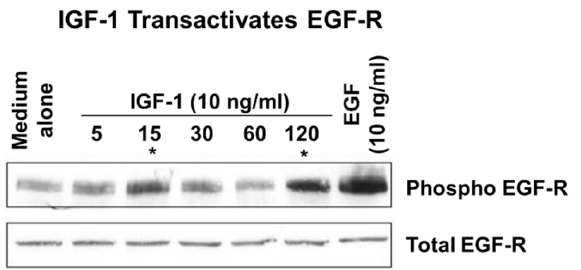
Figure 7. IGF-1 transactivates EGF-R in RGM1 cells. Treatment with IGF-1-phosphorylated EGF-R in a biphasic manner at 15 and 120-min. asterisk (*) denotes biphasic transactivation of EGF-R by treatment with IGF-1 at 15 and 120 min. (reprinted with permission from